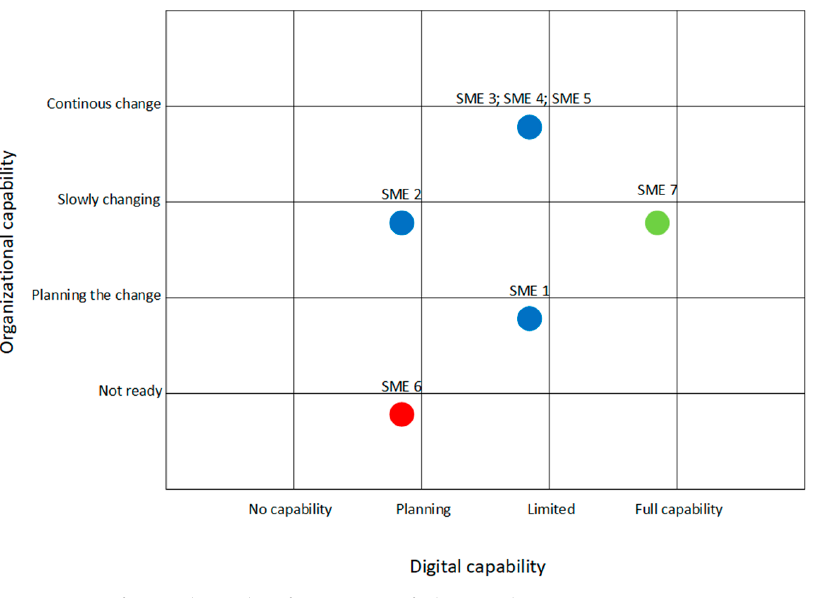
Figure 4. Defining the utility function— “ if–then ” rules.